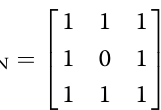
intensity at the surrounding eight positions of the